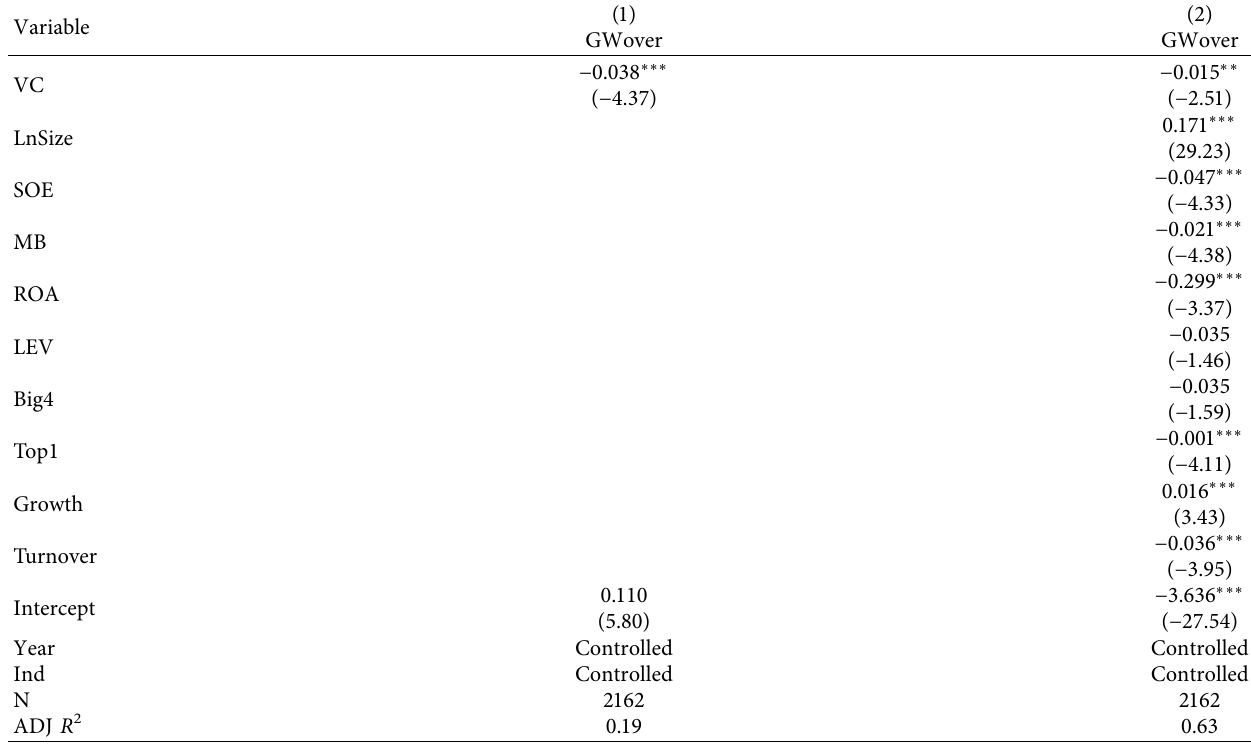
Table 4: Regression